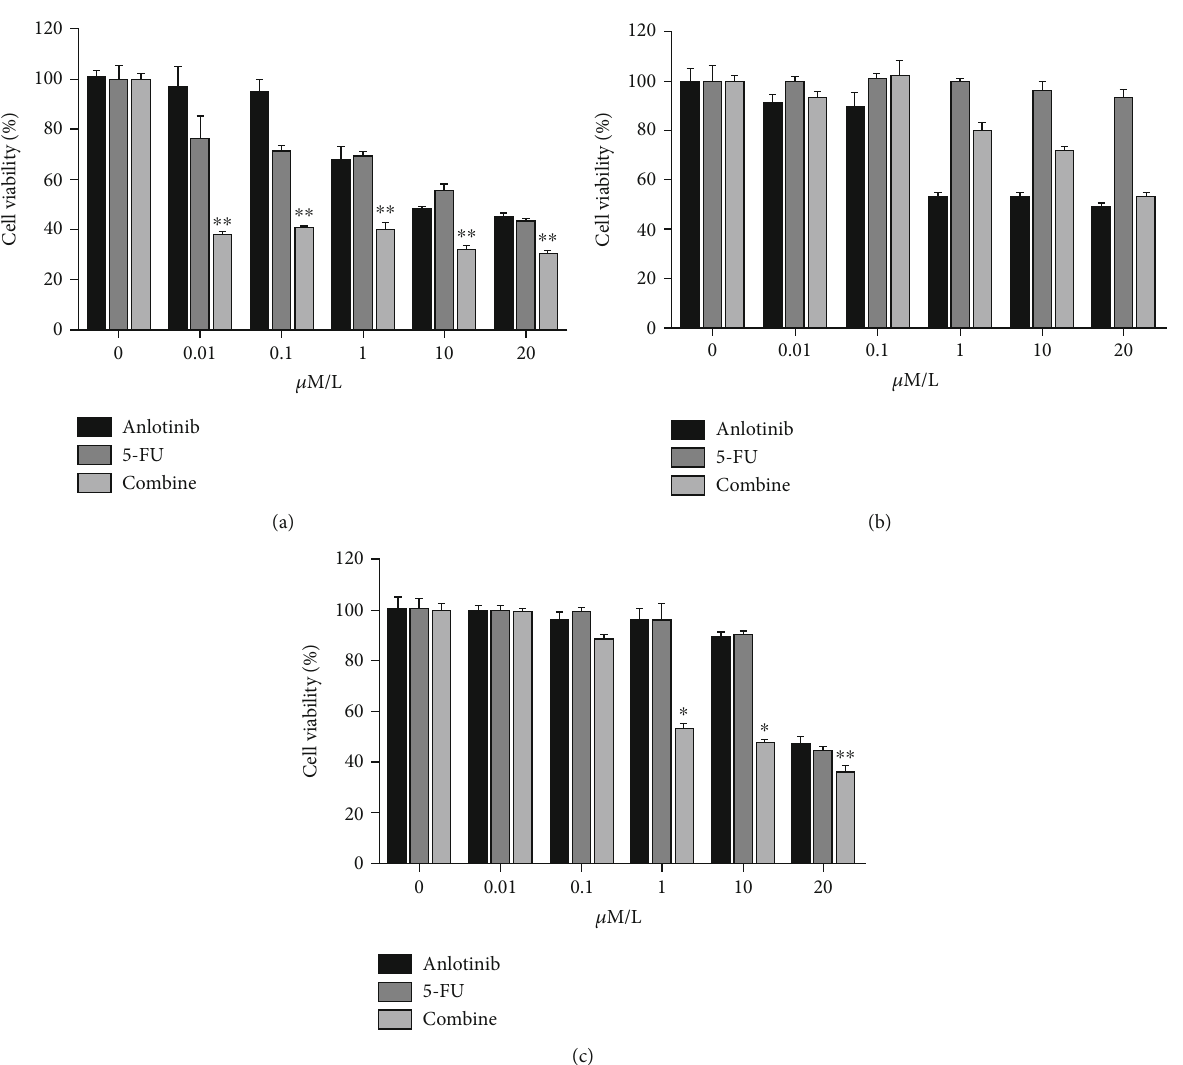
Figure 1: E ff ect of anlotinib combined with 5-FU in SCLC cell lines. The H446, H1688, and H187 cells were treated with anlotinib, 5-FU, or combination of both for 72h, and cell growth was detected using CCK8 kit. The inhibition rates in the (a) H446 cells, (b) H1688 cells, and (c) H187 cells following treatment with anlotinib and 5-FU in di ff erent drug concentrations (0 μ M, 0.01 μ M, 0.1 μ M, 1 μ M, 10 μ M, and 20 μ M) while 5-FU remained a fi xed concentration in the mixture. The bars represent mean ± SEM of the three independent experiments. ∗ P < 0 : 05 and ∗∗ P < 0 : 01 compared with anlotinib. SCLC: small-cell-lung